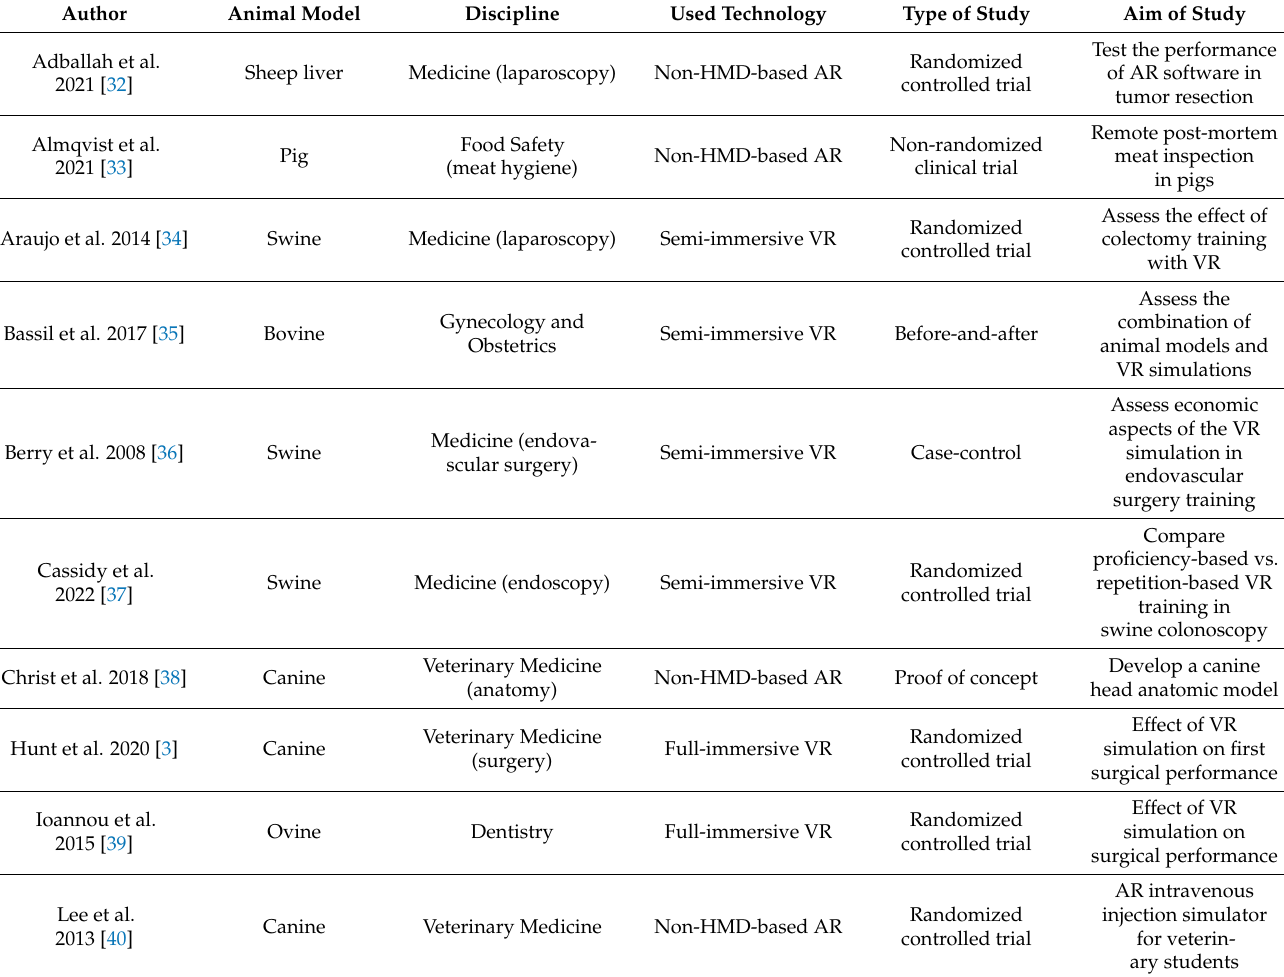
Table 1. Overview of studies included in systematic